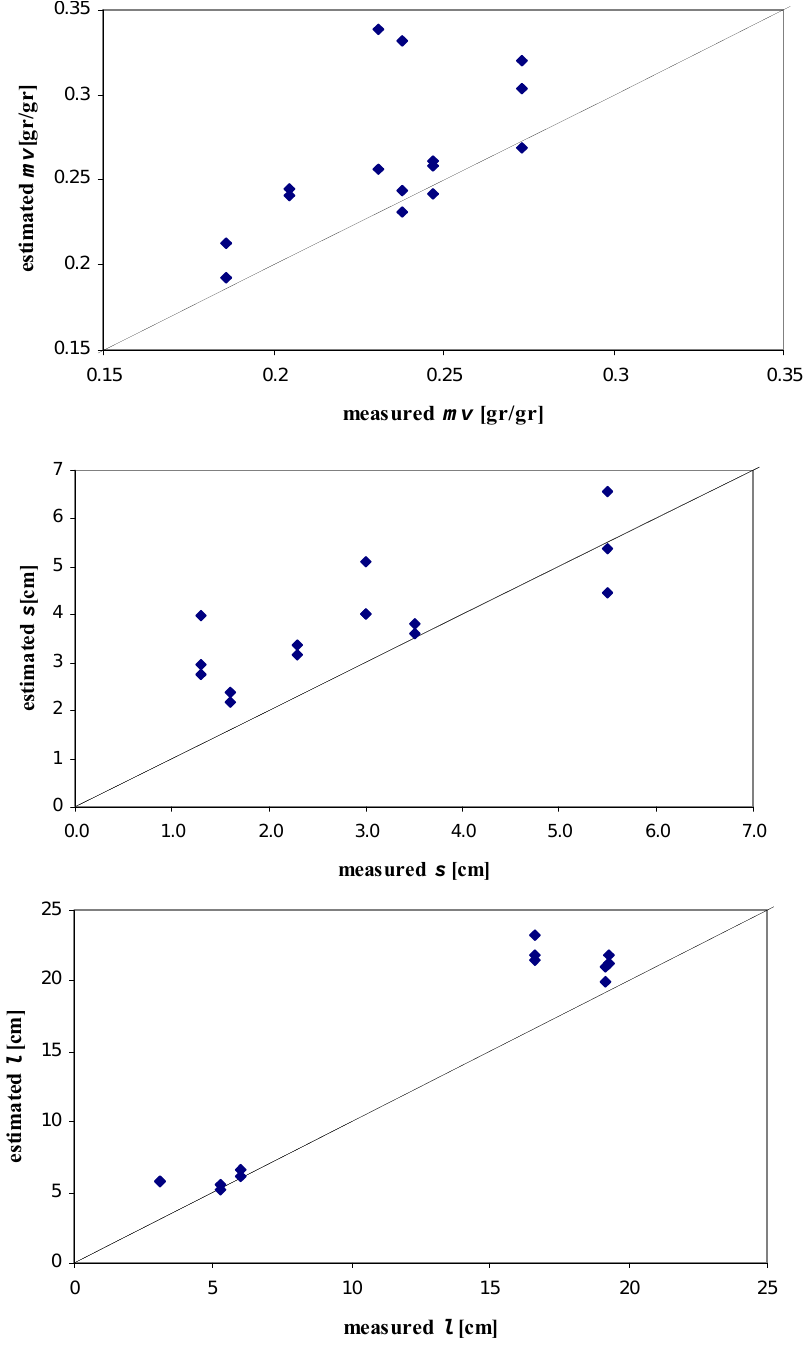
Figure 7 . MV estimated versus measured bare soil parameters for MAC and SIR-C campaigns. Upper, central and lower panel concern soil moisture, standard deviation of height and correlation length,